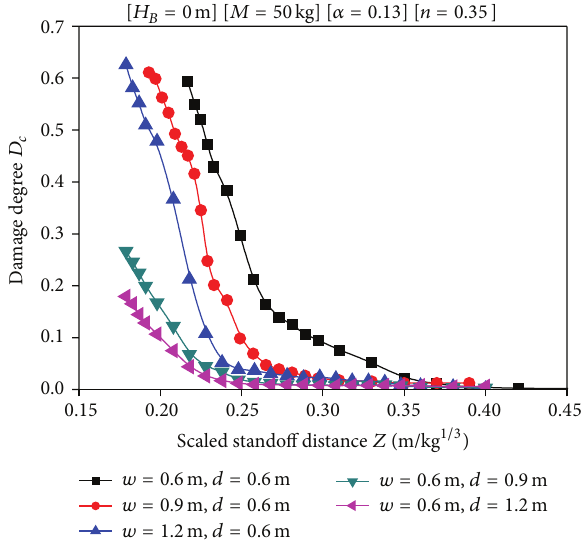
Figure 12: Effects of width and depth on the damage degree.